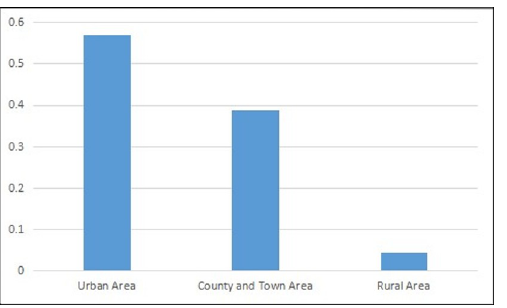
Fig 7. The geographical proportion of class number for special education (Unit: Proportion). Data source is China Education Statistics Yearbook .